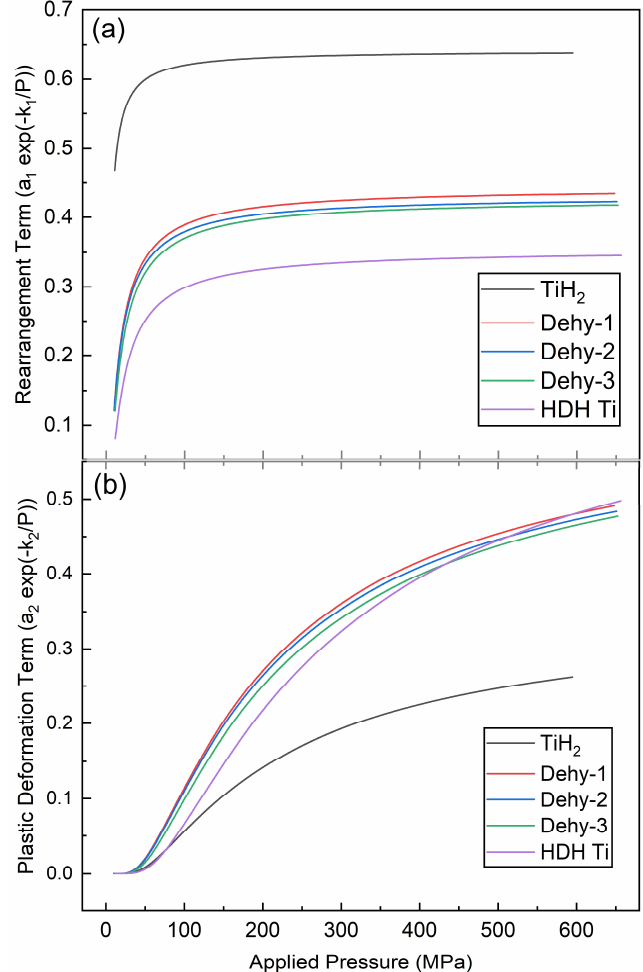
Figure 8. The contributions of particle rearrangement ( a ) and plastic deformation ( b ) mechanisms on densification according to Equation (2). The five powders are distinguished as follows: TiH 2 , Dehy-1, Dehy-2, Dehy-3 and HDH Ti.